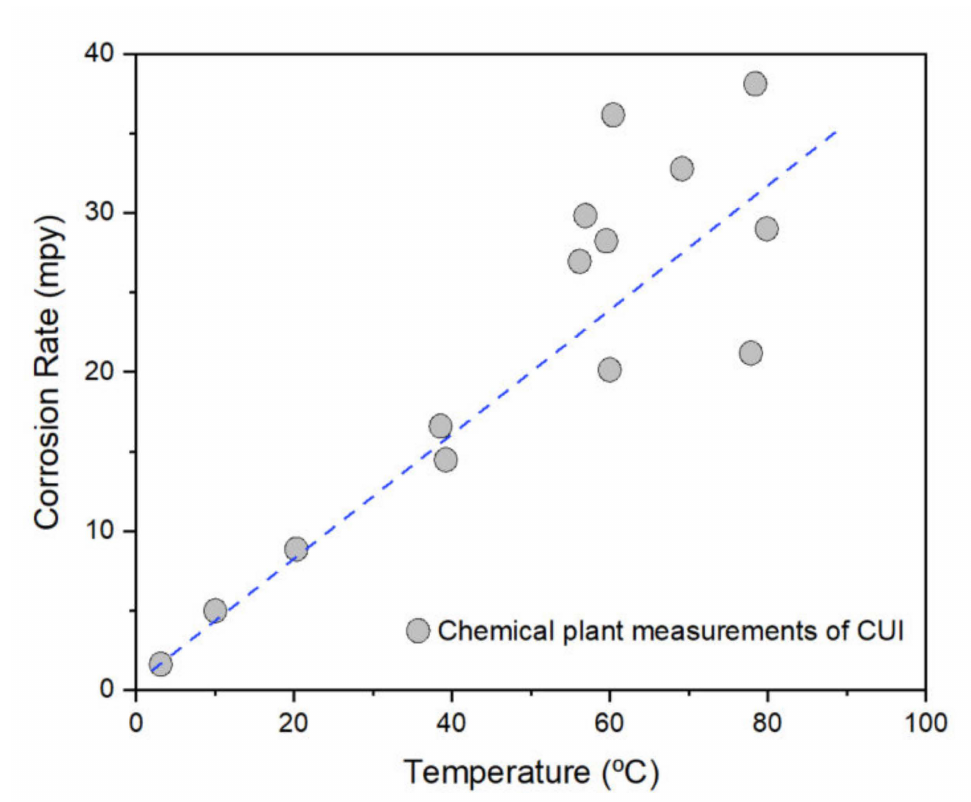
Figure 5. Effect of temperature on steel corrosion in water